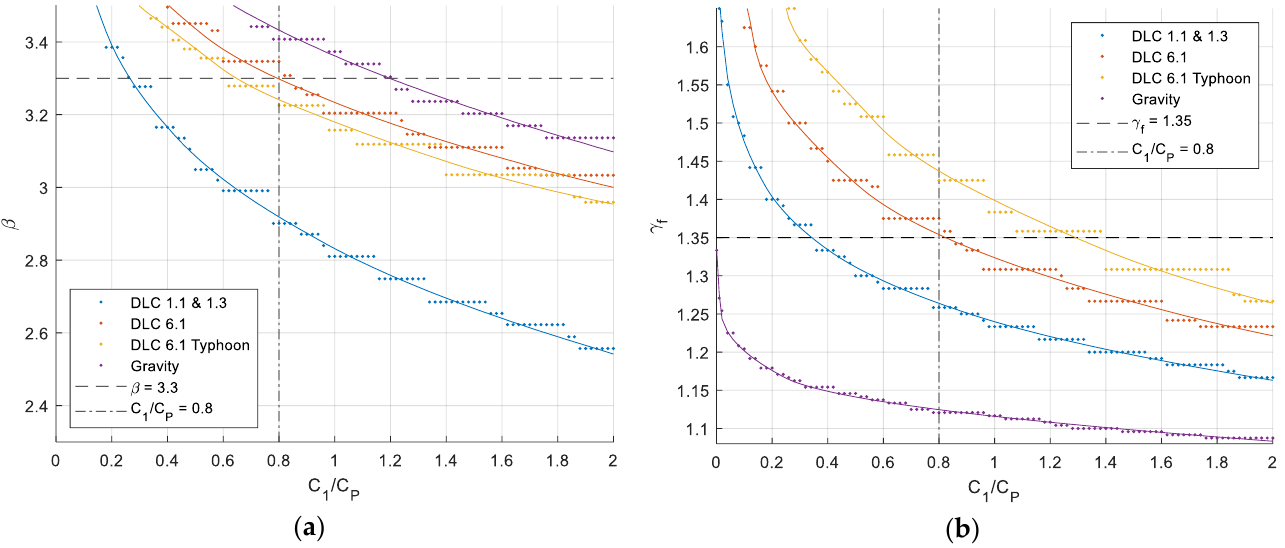
Figure 4. The optimal value of ( a ) annual reliability index (in the first year), ( b ) load safety factor for 𝐻/𝐶 = 1 . The dots correspond to optimal values of the design parameter among the ones where reliability analyses were performed, and the lines are obtained by using a cubic smoothing spline on the expected profit Z(z) and then finding the optimal on that spline.